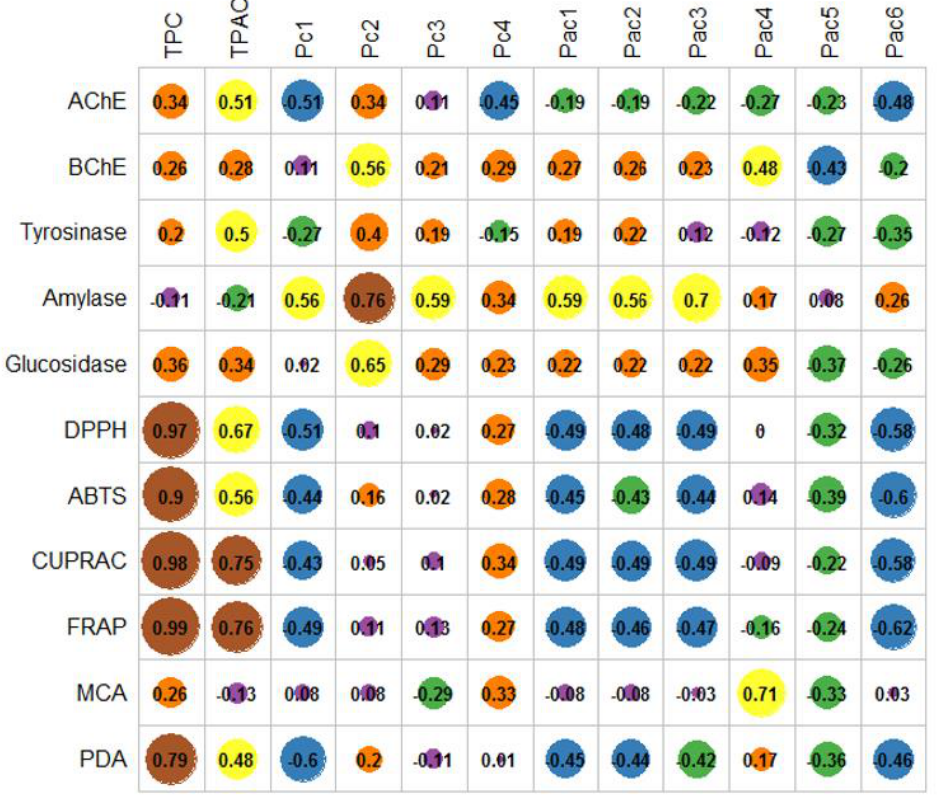
Figure 5. Correlation analysis between the phytochemical composition and biological activities.